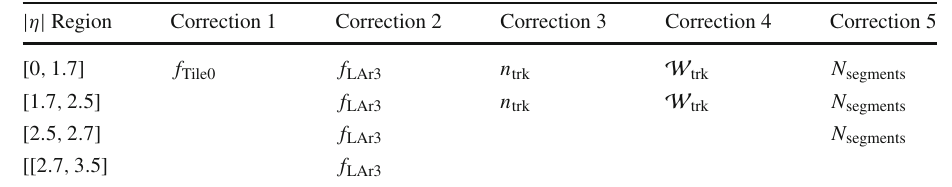
corrections used to improve the jet performance in each η det region. For jets at the LCW+JES scale, only the tracking and uncontained calorimeter jet corrections are